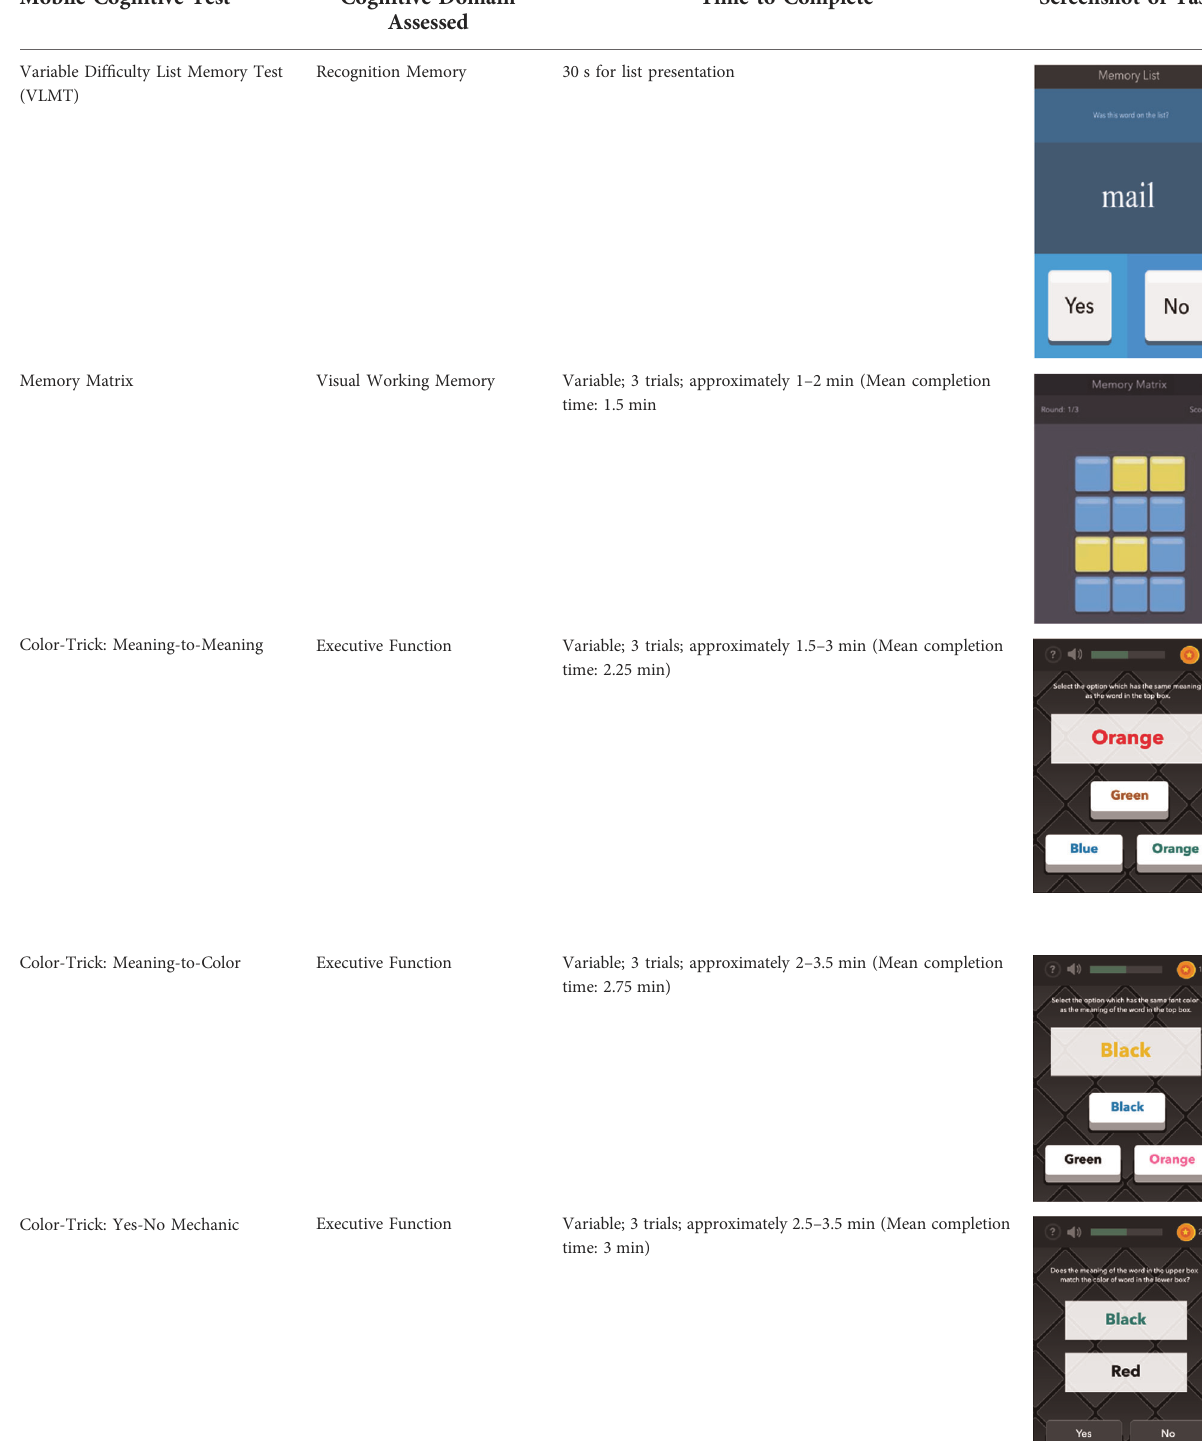
TABLE 1 Mobile cognitive tests. Mobile Cognitive Test Cognitive Domain